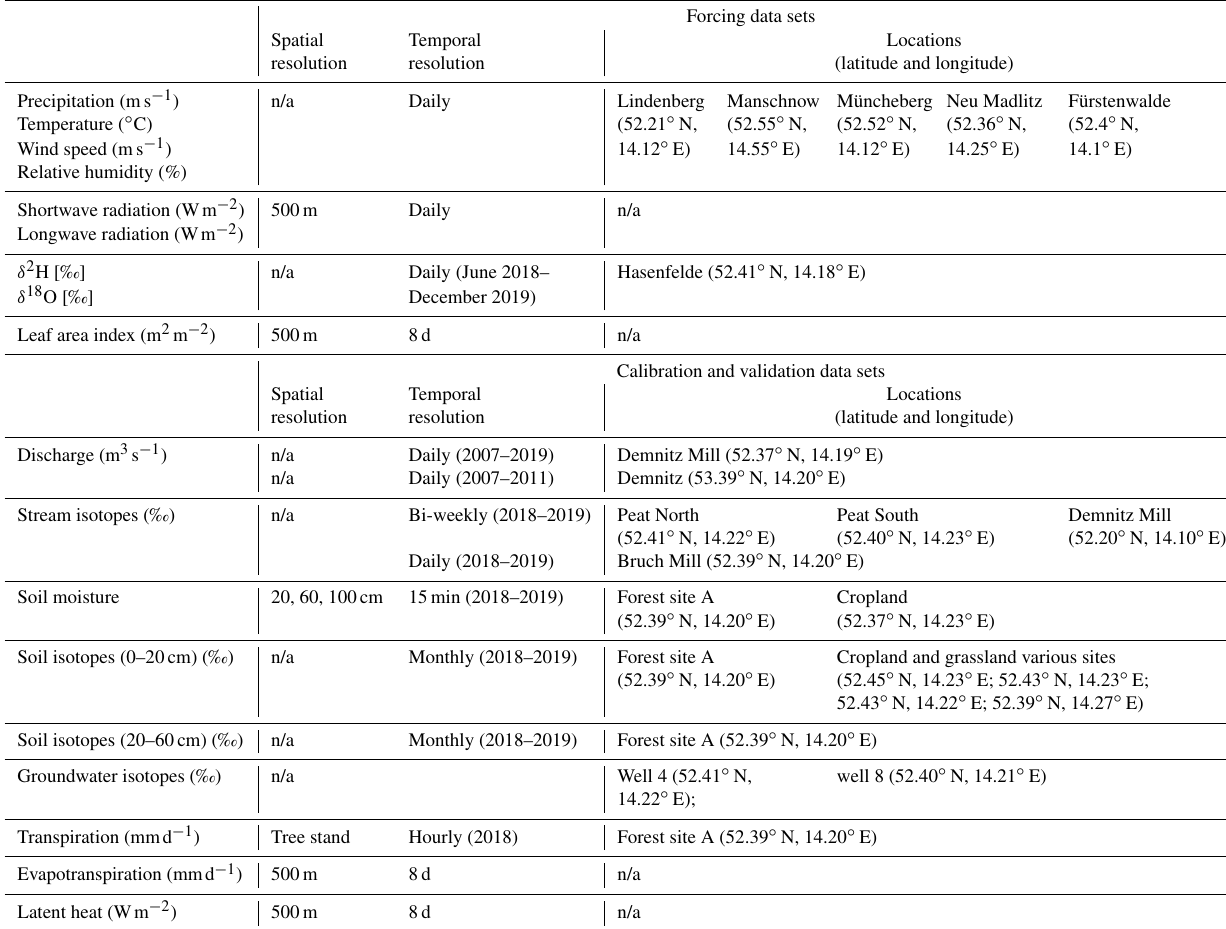
Table 1. Demnitzer Millcreek catchment climate data spatial and temporal resolutions from nearby weather stations, site collection, reanalysis data (short and longwave radiation; ERA5) and remote sensing data (leaf area index, latent heat, and ET; MODIS) used for daily modelling. Note: n/a – not